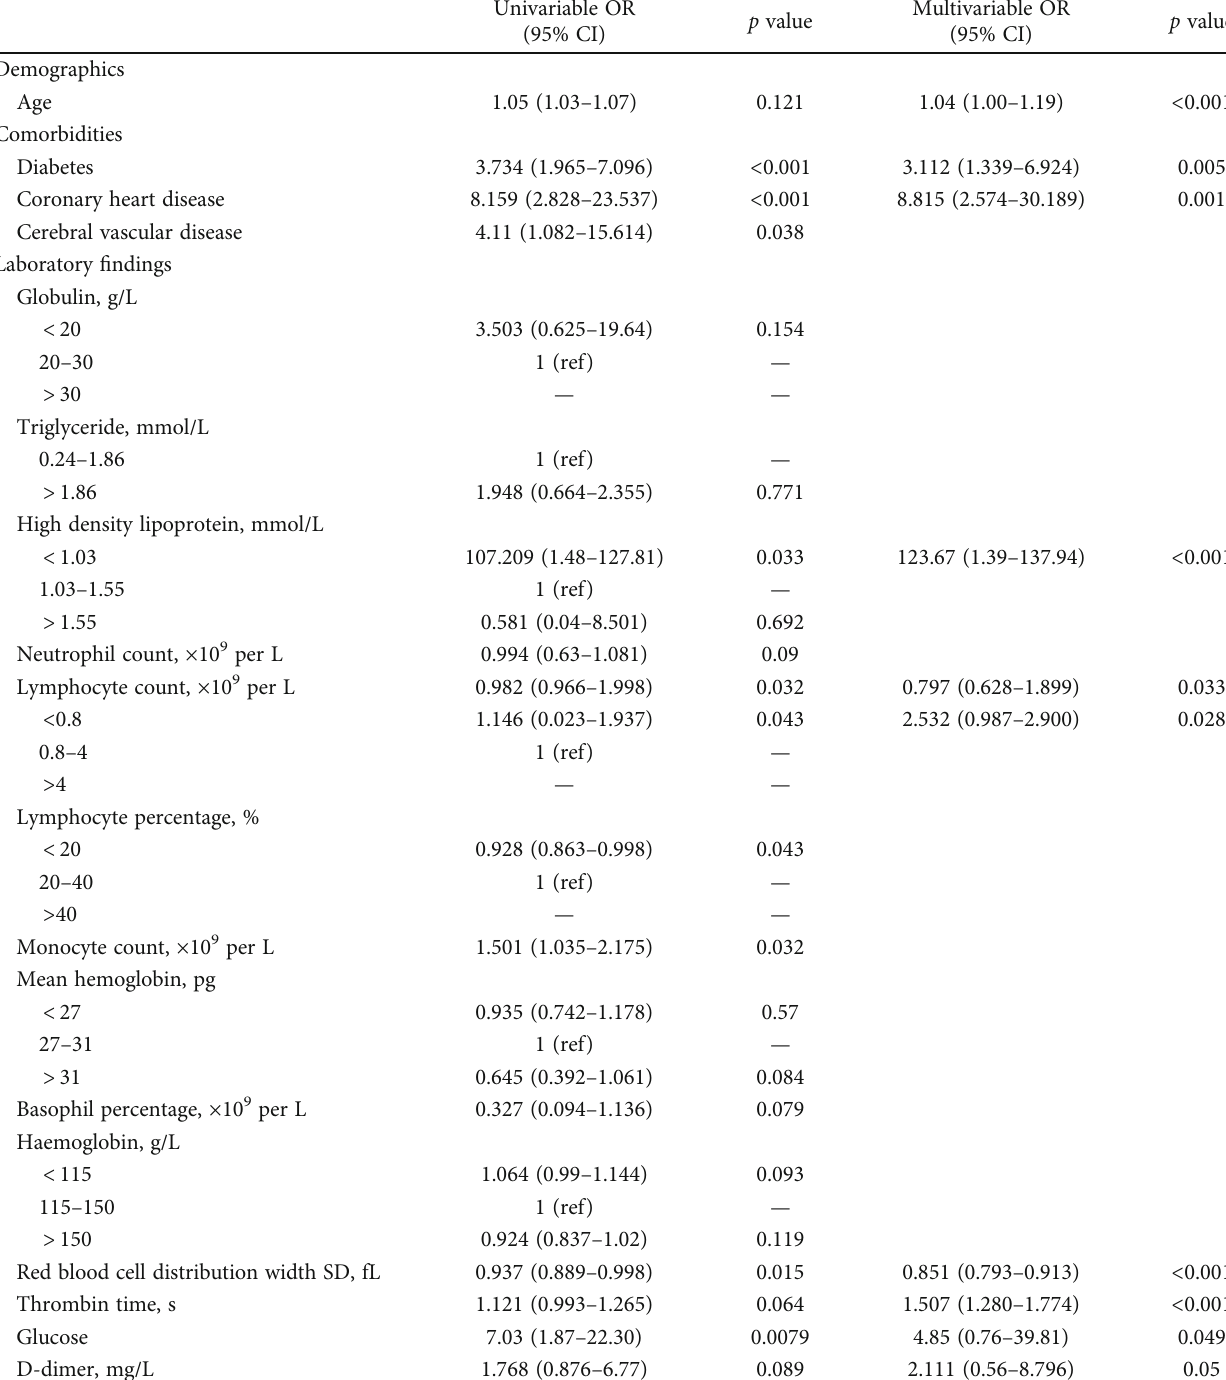
Table 4: Risk factors associated with COVID-19 patients with